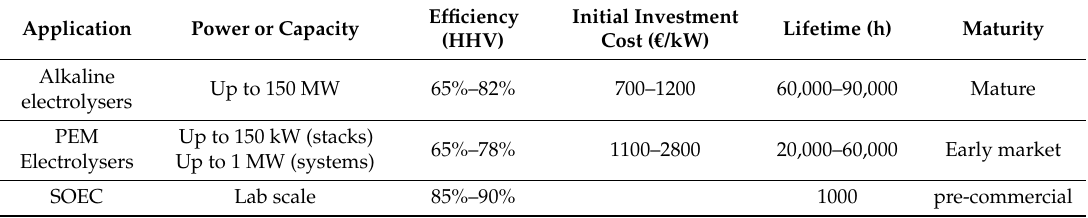
Table 3. Current performance of hydrogen generation technologies by renewables.